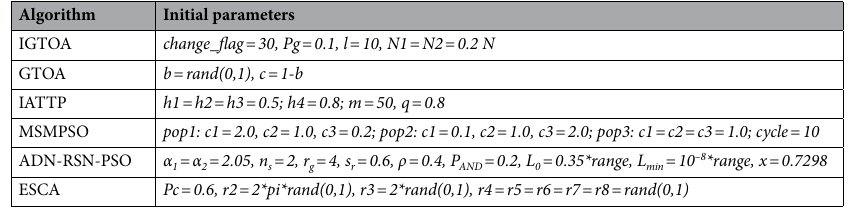
Table 4. Initial parameters setting of each algorithm.